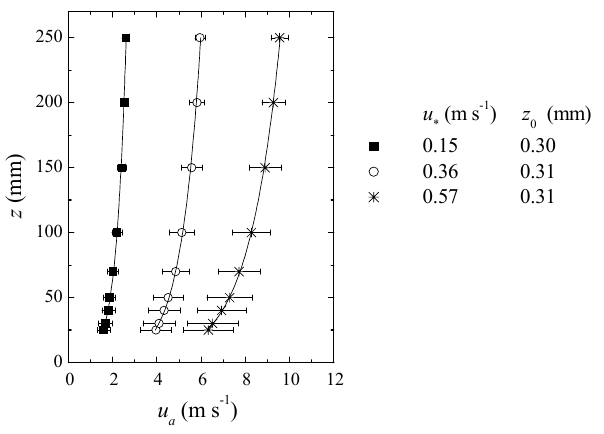
Figure 9. Wind profiles measured over the water surface for three experiments with the fan speed set to 3000, 9000 and 12000rpm. The dots are the mean wind speeds, and the error bars show the standard deviations. The curves are the logarithmic profiles fitted to the data.